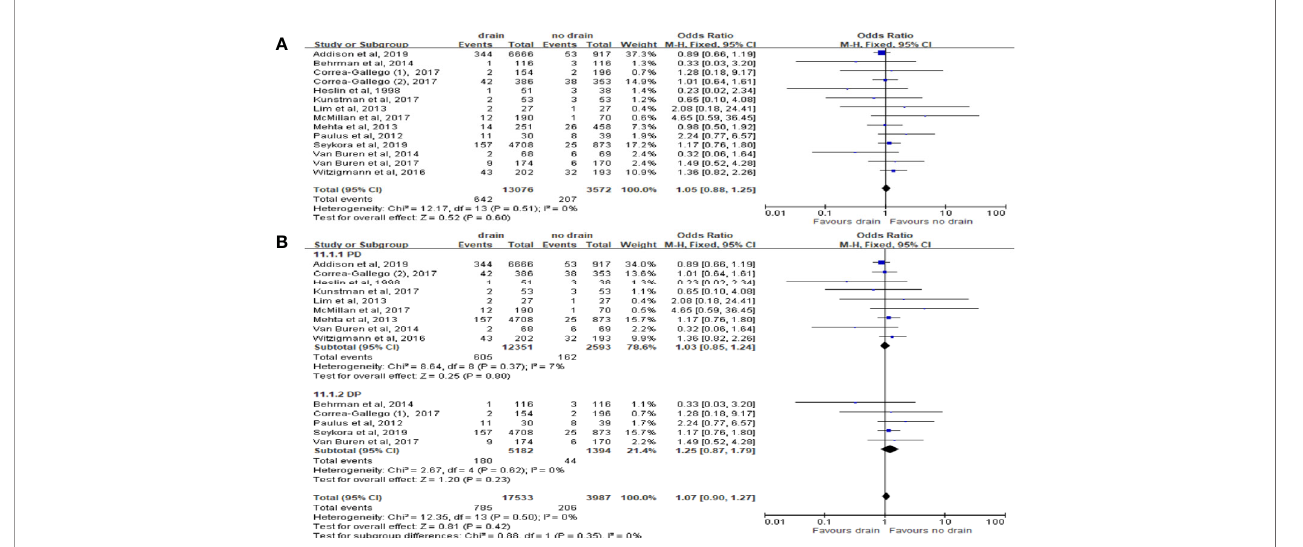
FIGURE 13 | Forest plot of the comparison of the rate of reoperation in drain versus no-drain groups after pancreatic resection. (A) Comparison in overall; (B) comparison in PD and DP subgroups,